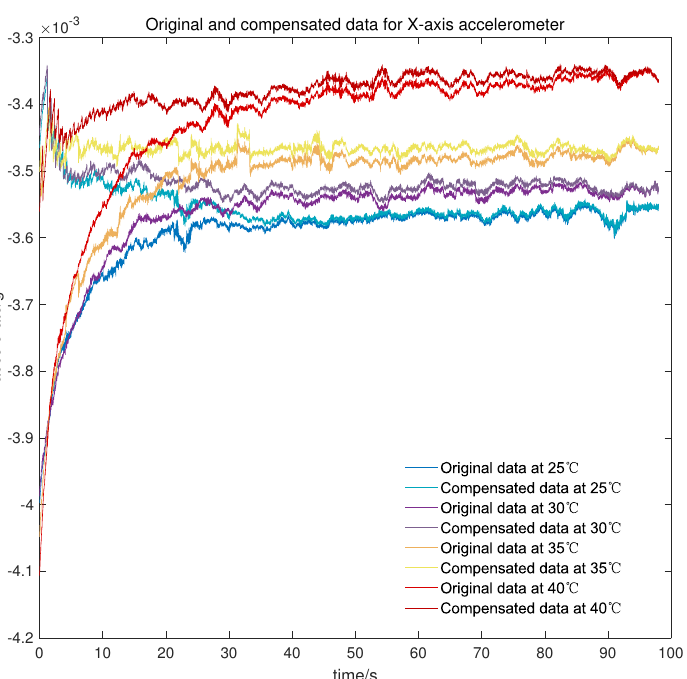
Figure 10. Original and compensated data for X -axis accelerometer at different temperature points.